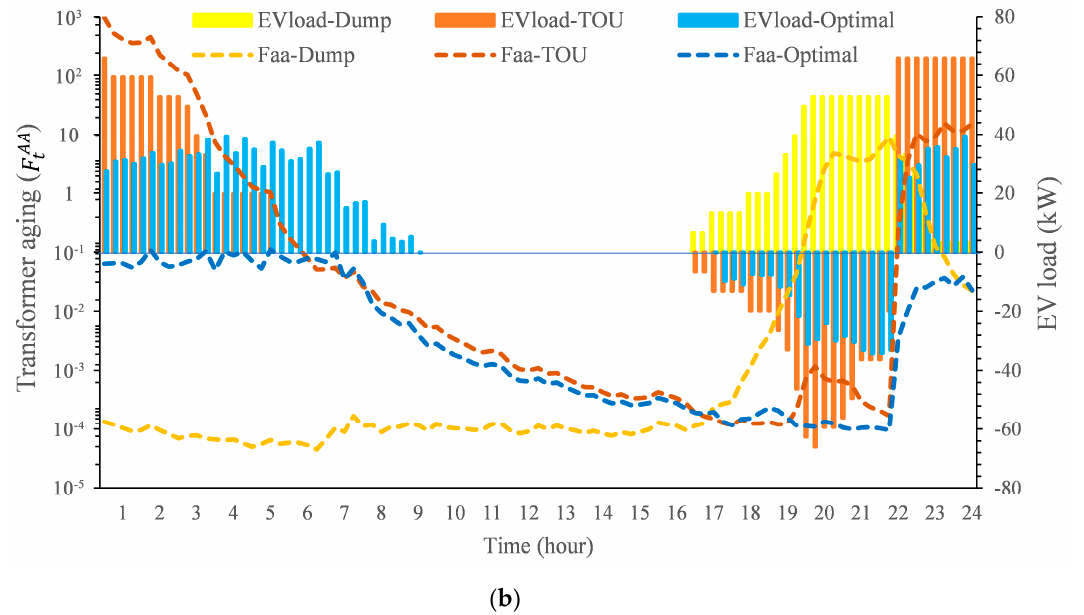
AA F ) versus EVs charging load in summer ( a ) and t AA ) versus EVs charging load in summer ( a ) and F ) versus EVs charging load in summer ( a ) and t t